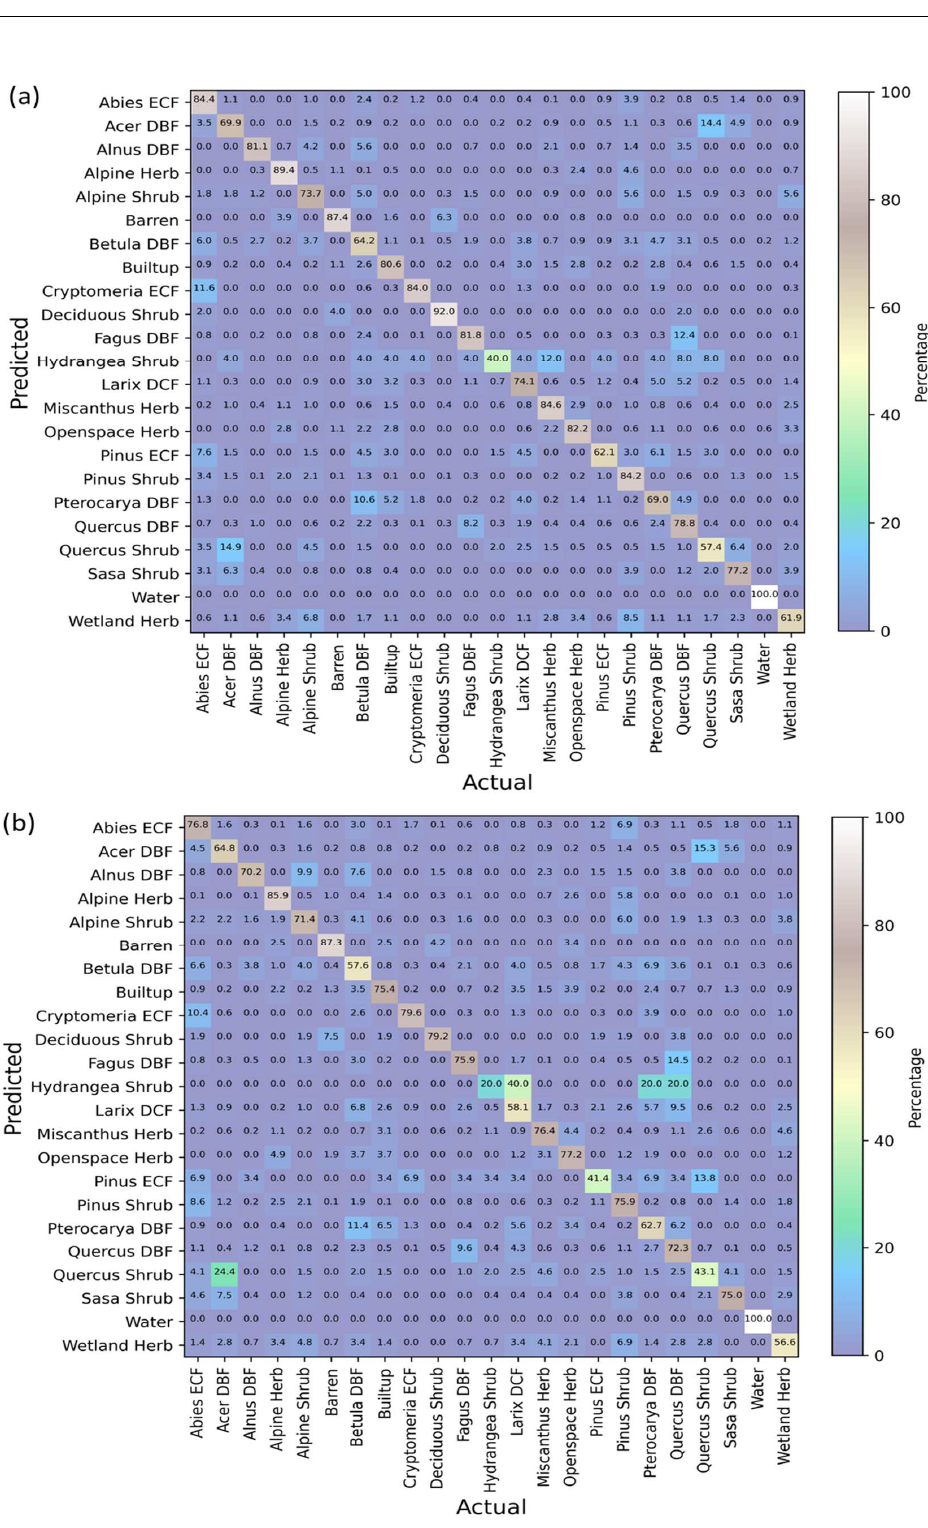
Figure 10. Performance of the ultra-resolution suite ( a ) over the very high-resolution suite ( b ) for the differentiation of land cover and vegetation types in the Zao site using bi-seasonal images.